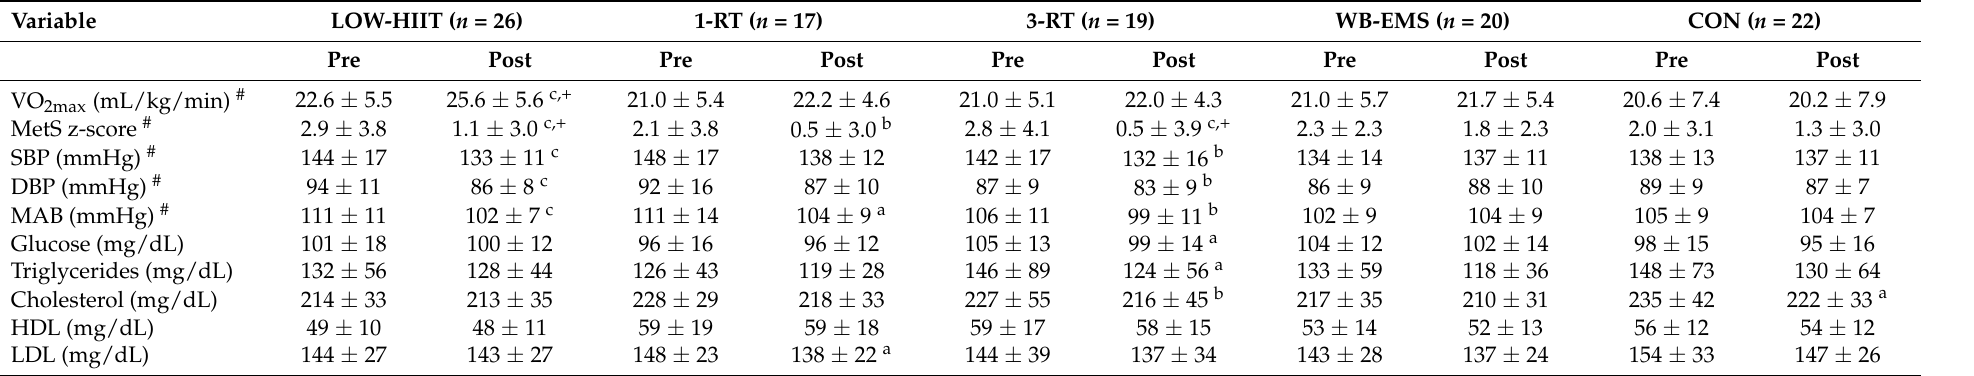
Table 6. Cardiometabolic markers before and after the